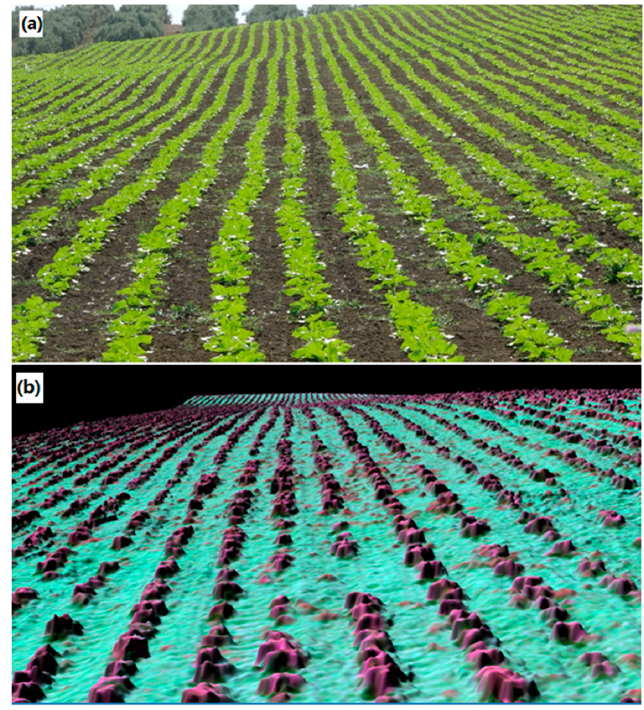
Figure 3. ( a ) Detail of one of the studied sunflower fields; ( b ) A partial view of the corresponding DSM produced by the photogrammetric processing of the remote images taken with the UAV.